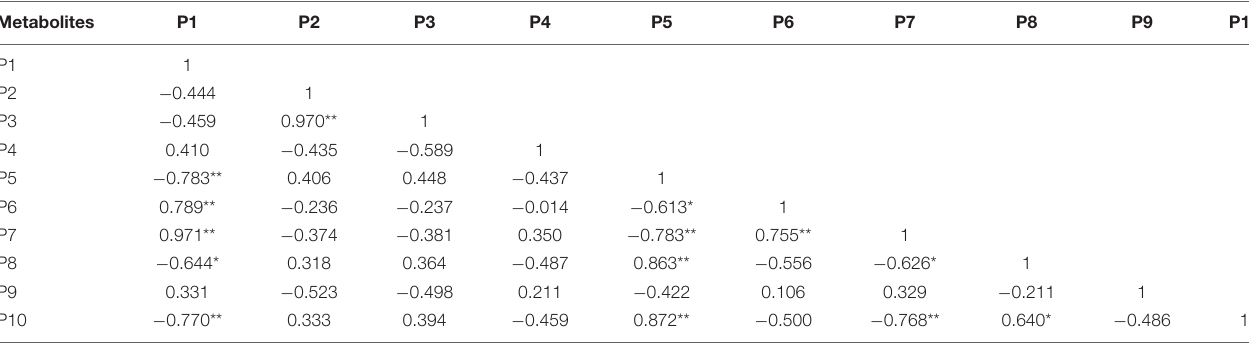
TABLE 3 | The correlation of significant different metabolites of the top 10 in positive ion mode (top 10).